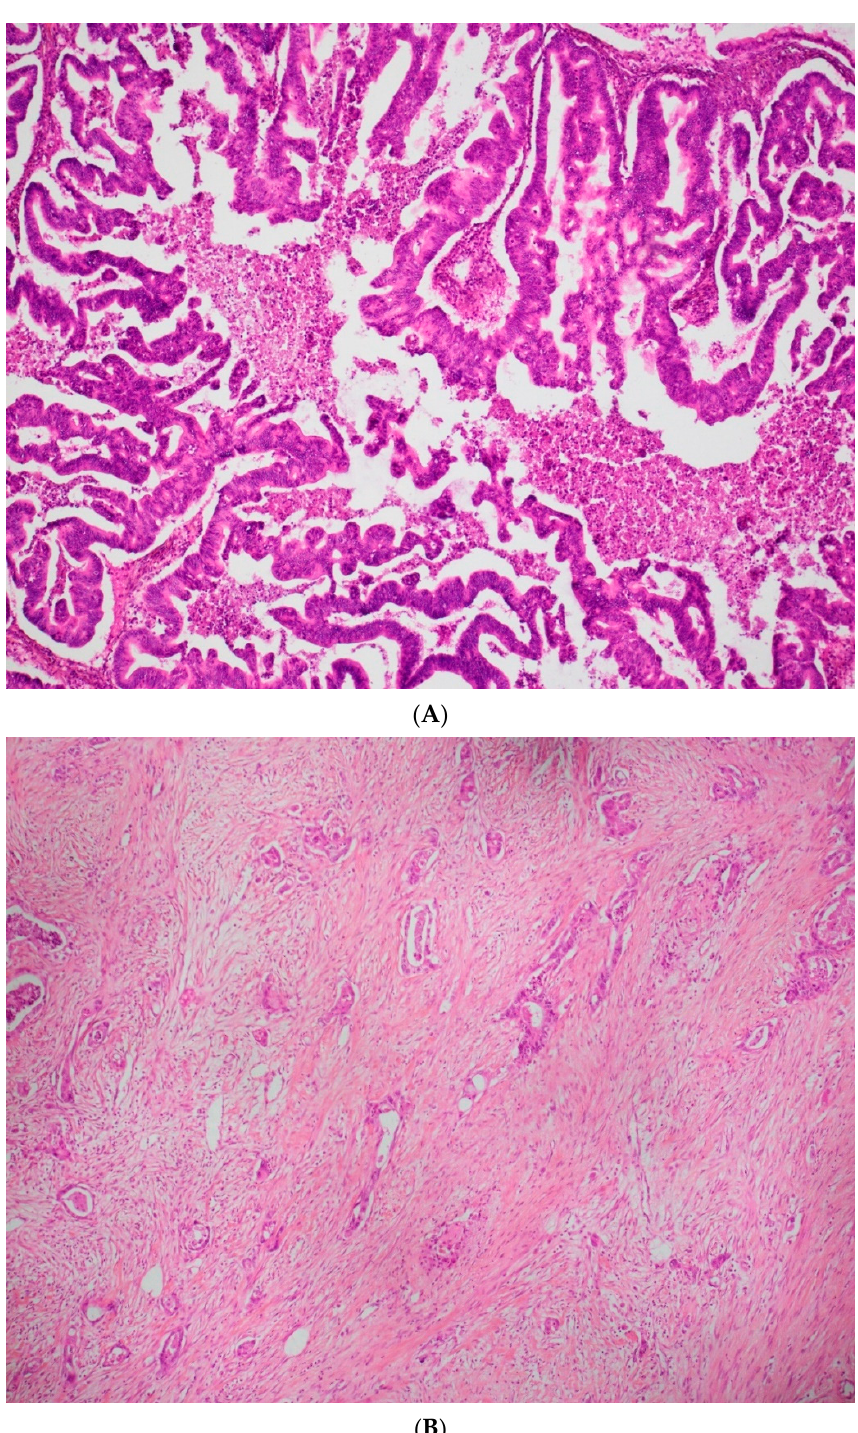
Figure 1. ( A ) ×20 H&E image with expansile/confluent mucinous carcinoma. ( B ) ×20 H&E image Figure 1. ( A ) × 20 H&E image with expansile/confluent mucinous carcinoma. ( B ) × 20 H&E image with infiltrative/destructive mucinous carcinoma. with infiltrative/destructive mucinous